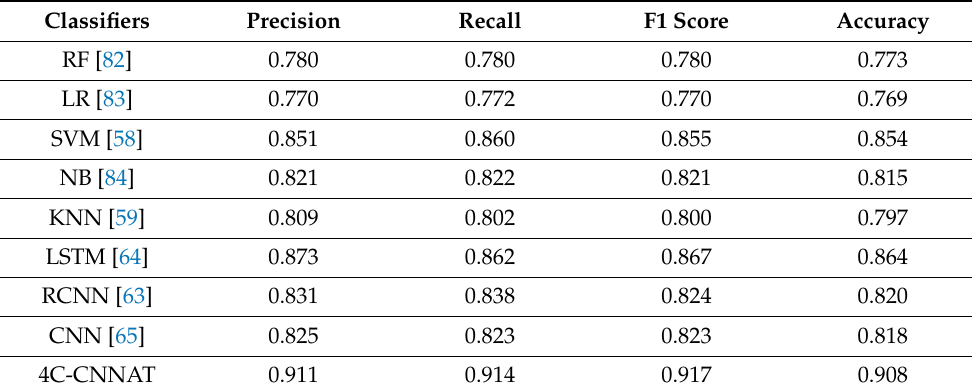
Table 6. 4C-CNNAT performance comparison with various ML/DL classifiers using RUR